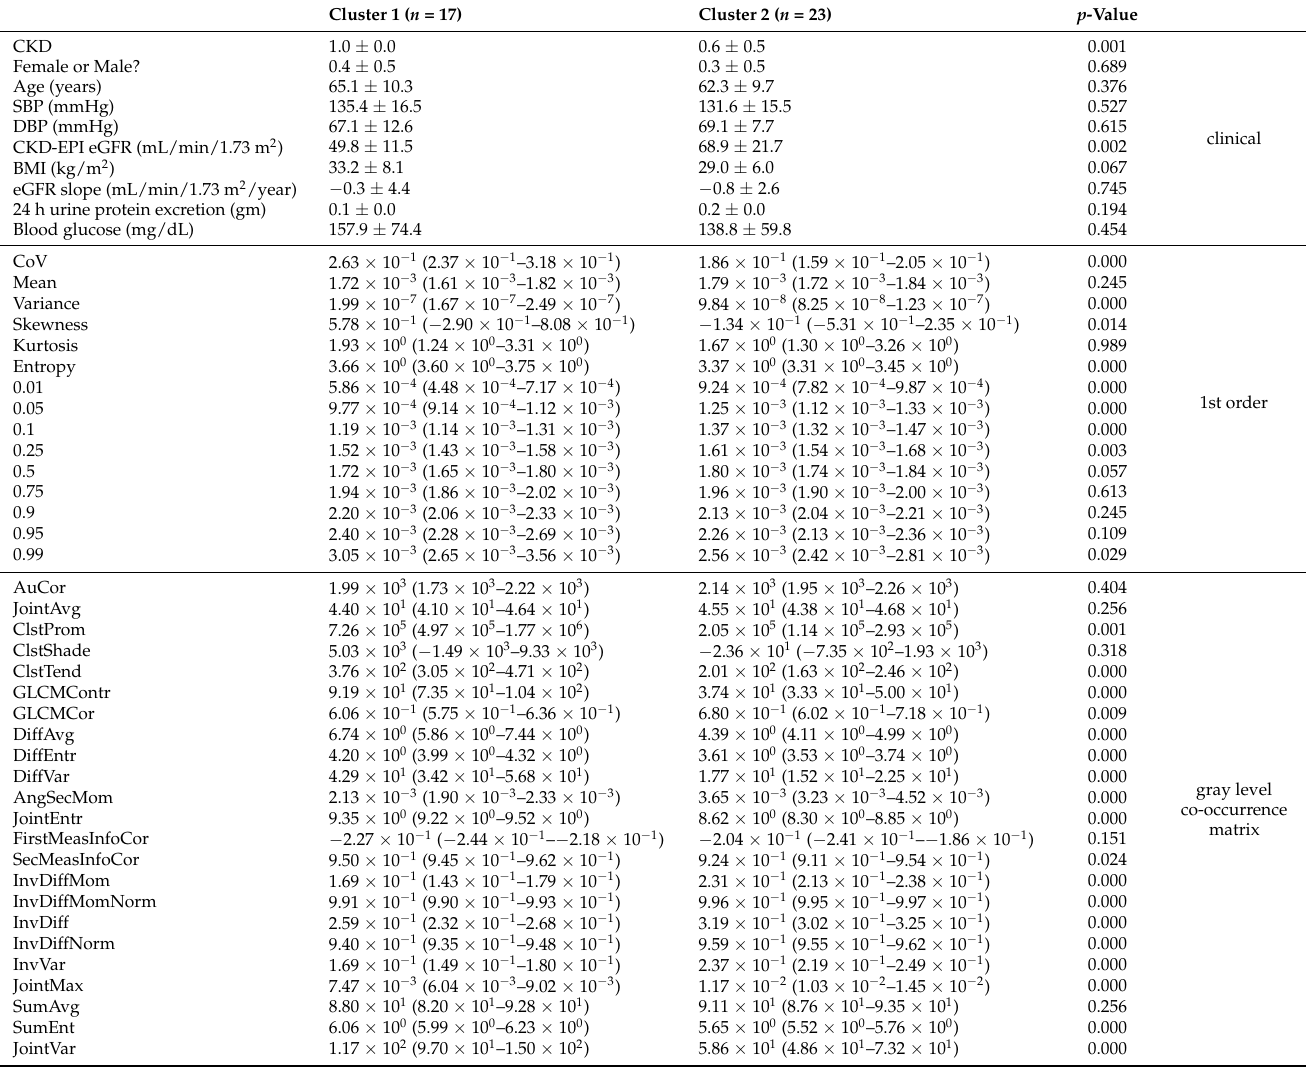
different between clusters that were not different between the CKD and healthy groups, including skewness, 0.99, JointMax, GLCMCor, and ClstProm. Table 3. Differences in clinical and radiomic features between two